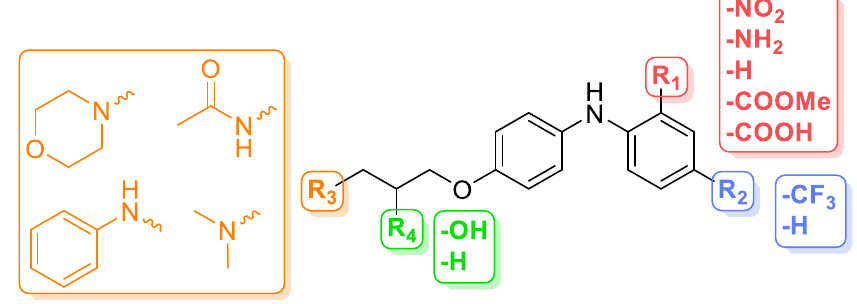
Figure 11. Design of the hit compound ZVS-08 analogues.